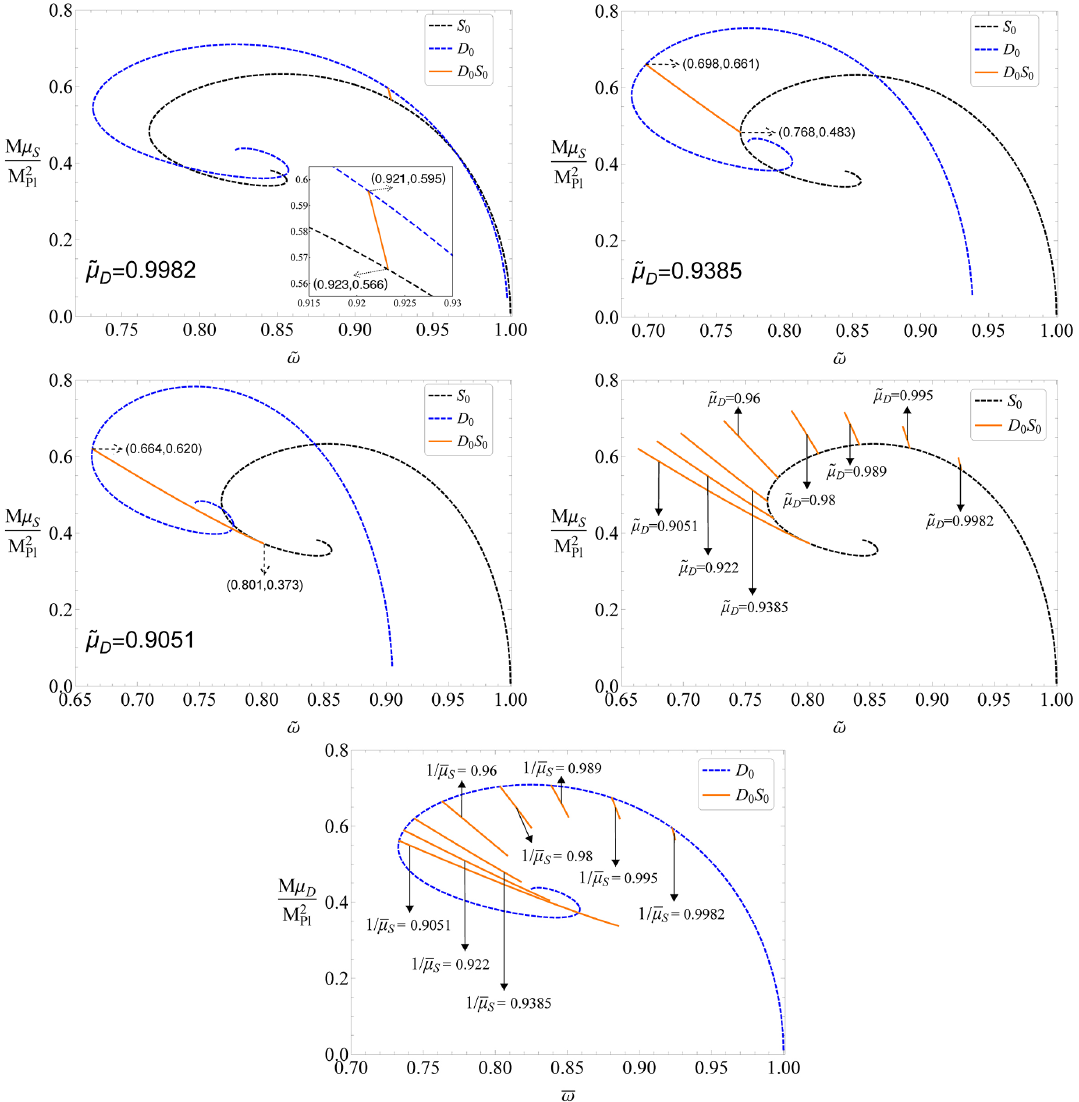
Figure 2. Top and middle panels : the ADM mass M of the DBSs as a function of the synchronized frequency ˜ ω for several values of the mass ˜ µ D , all solutions have ˜ µ S = 1 . Bottom panel : same data as middle right panel but for ρ = 1 /µ D , where ¯ ω = ω S /µ D = ω D /µ D = ˜ ωµ S /µ D , ¯ µ S = µ S /µ D = 1 / ˜ µ D , all solutions have ¯ µ D = ρµ D = 1